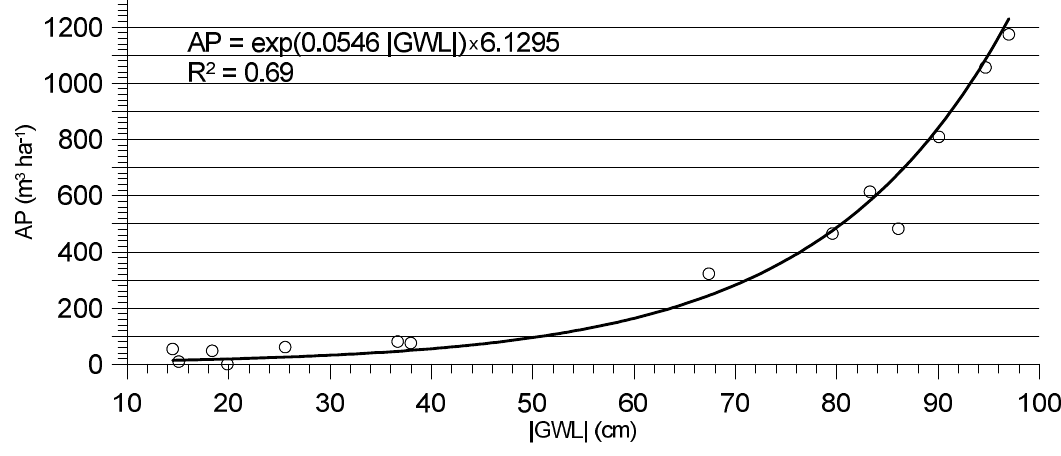
Figure 9. Relationship between groundwater level (GWL) and air porosity (AP).